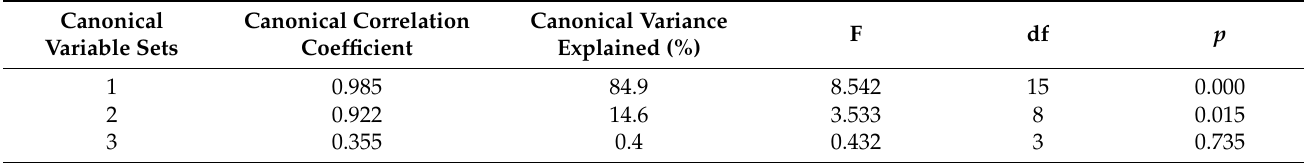
Table A4. Canonical correlation coefficients for canonical variable sets for biotic and environmental